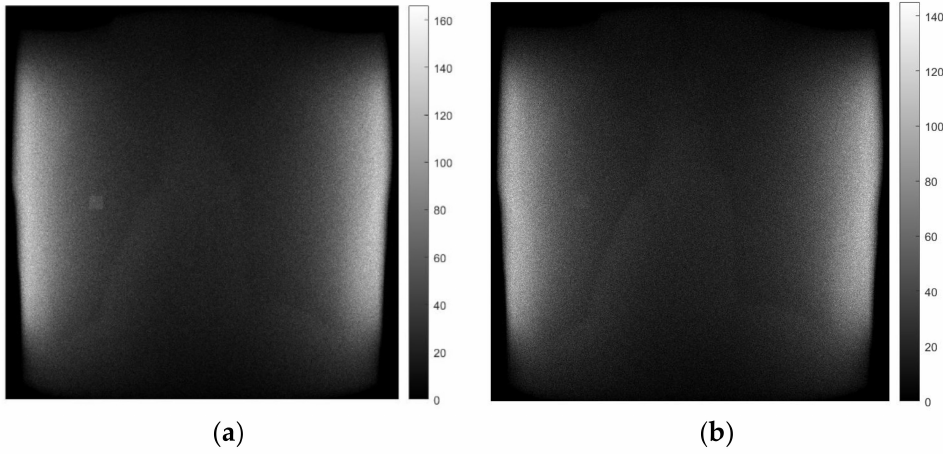
Figure 23. Fluorescence images for ( a ): Au-K α 2 (67.1–67.2 keV); ( b ): Au-K β 1 (77.8–77.9 keV)